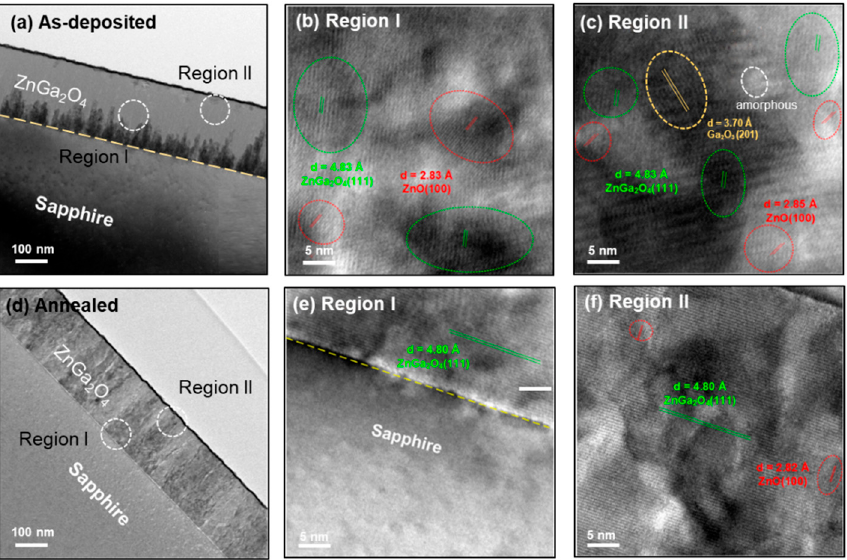
Figure 3. Cross-sectional and HRTEM micrographs of ( a ) as-deposited, ( b ) region I, ( c ) region II of as-deposited ZnGa 2 O 4 film, ( d ) annealed, ( e ) region I, and ( f ) region II of annealed ZnGa 2 O 4 film under air ambience.